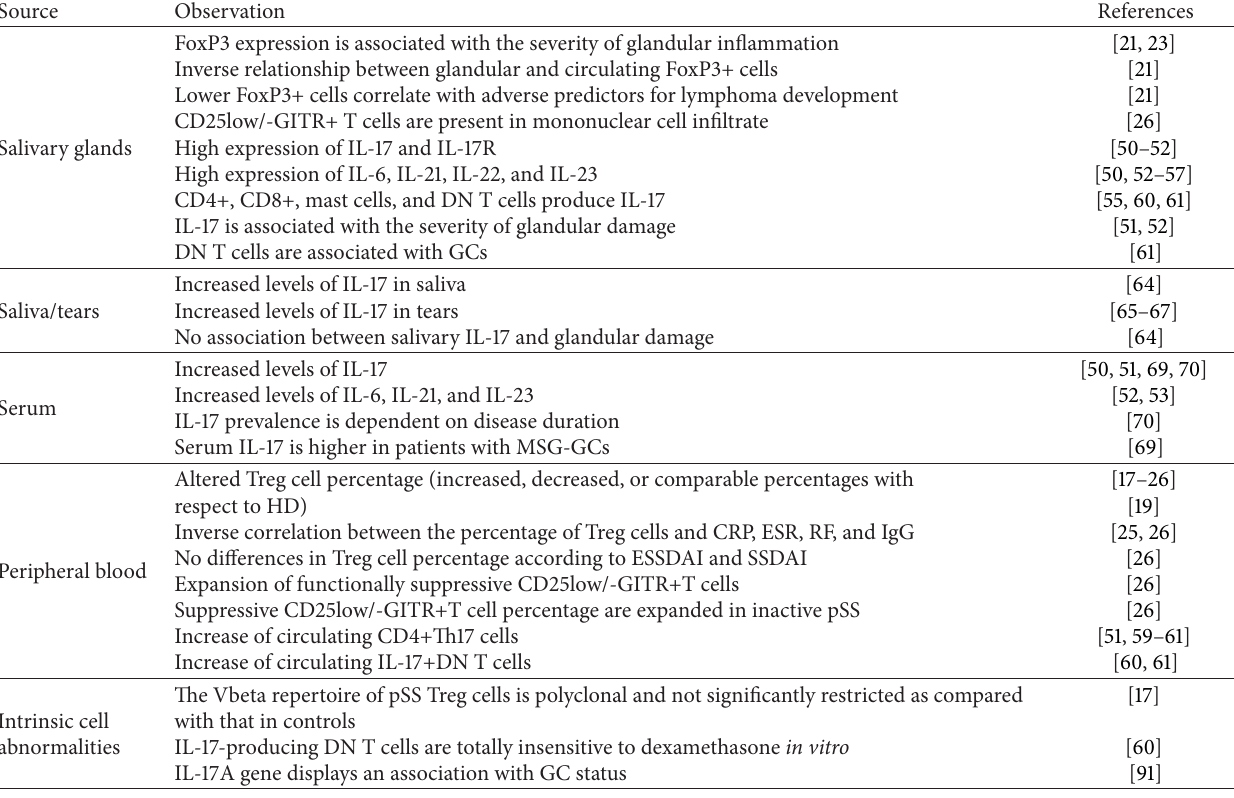
Table 1: Indicators of Treg cell and IL-17/IL-17-producing T cell involvement in primary Sj¨ogren’s syndrome. Source Observation